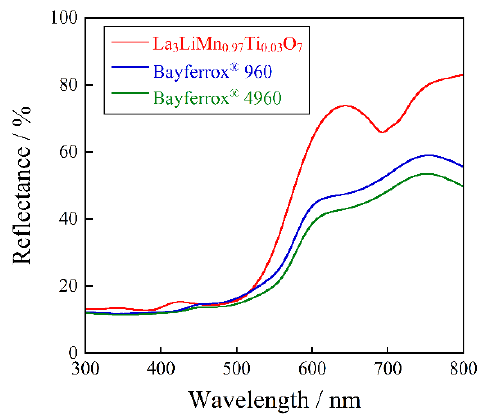
® 960 and Bayferrox ® 3 LiMn 0.97 Ti 0.03 O 7 , Bayferrox